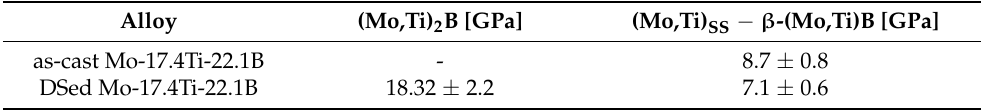
Table 2. Microhardness (HV0.1) of the Mo-Ti-B alloys.